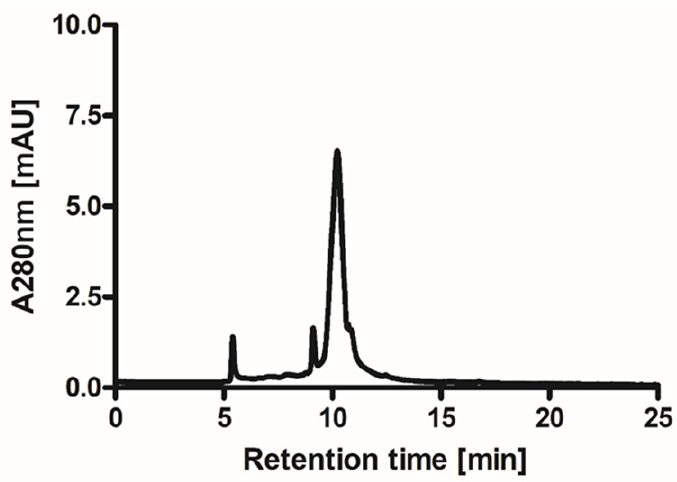
Figure 2. HPLC gel filtration is the final ovocystatin preparation. Twenty microliters of the sample were loaded on the Bio SEC-5 column and eluted with 150 mmol/L sodium phosphate, pH 7.4. Protein in the eluent was detected by UV absorption measurement at 280 nm. The retention time determined for ovocystatin was 10.2 min.